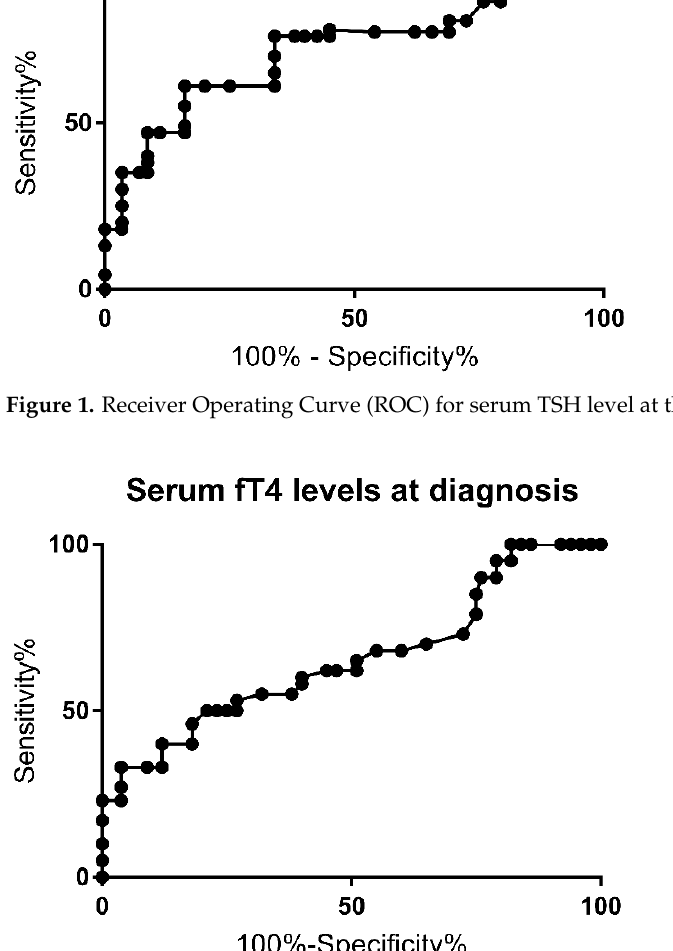
Figure 1. Receiver Operating Curve (ROC) for serum TSH level at the time of diagnosis.